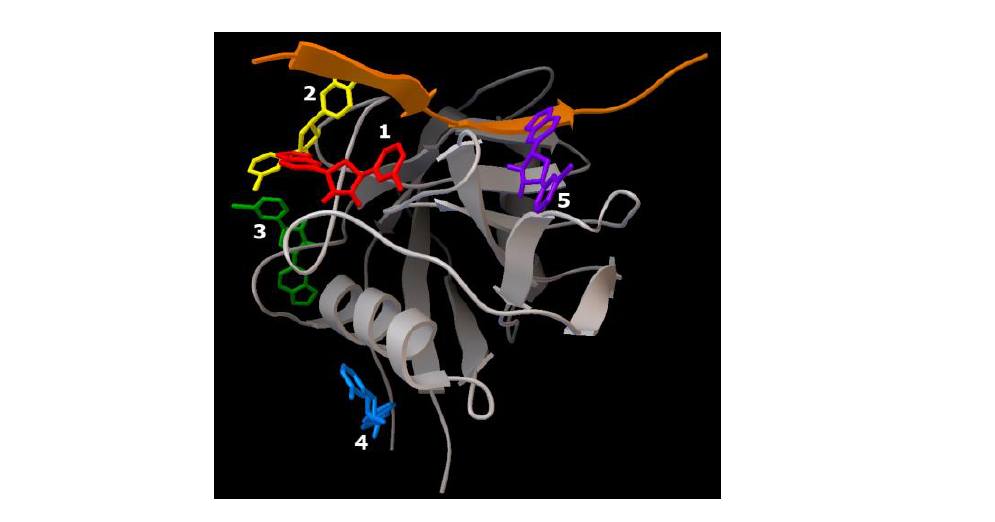
Figure 9. Five binding sites of the Anle138b isomer ligand of the complex of the A α Syn fragment and cyclophilin (PDB ID 6I42). Individual Anle138b isomer ligands have the following: 1—red, 2—yellow, 3—green, 4—blue, 5—violet. Table 3. Interactions of five Anle138b isomer ligand molecules with complex A α Syn–CypA (PDB ID 6I42). short peptide strand of AαSyn), the distribution of binding sites for all five Anle138b